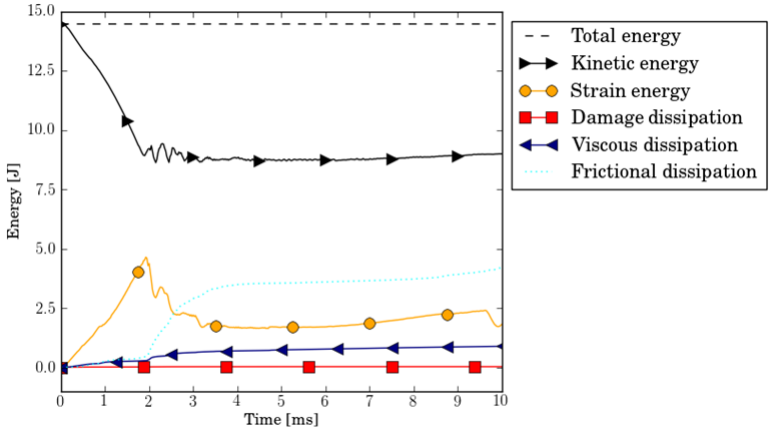
Fig. 14 Evolution of energies in simulation of glass with Hillerborg material model under drop weight